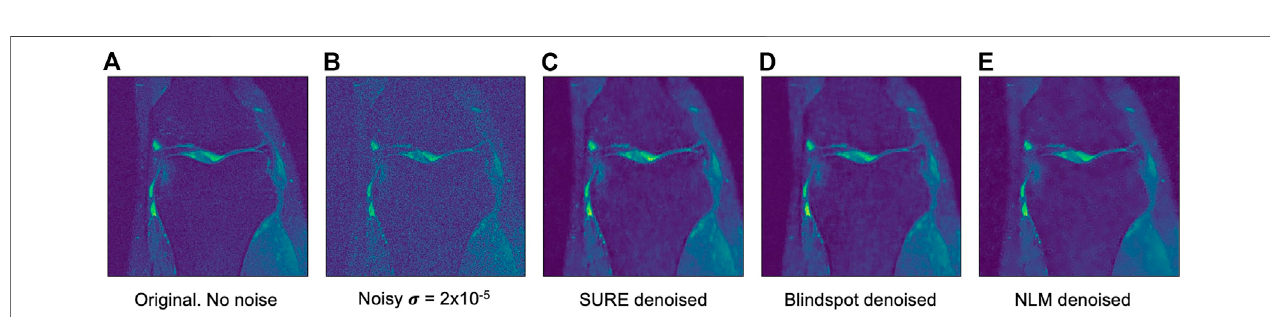
FIGURE6| Example ofdenoisedknee MRIfor σ (cid:1) 2 × 10 − 5 .Theexampleimageisthemiddleslicefromoneofthesubjects.Inthiscase,thisisthePSNRforevery